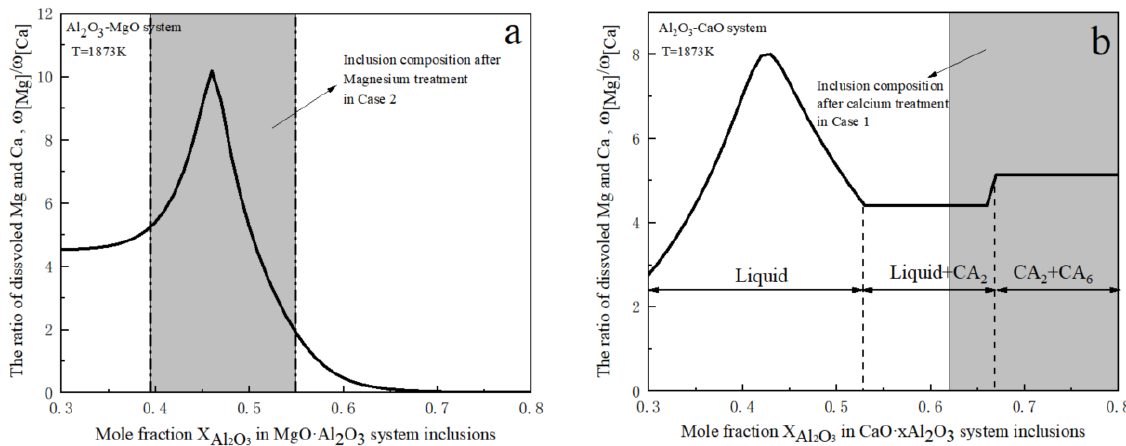
Figure 12. Ratio of Mg to Ca required for mutual transformation between Al 2 O 3 ·MgO ( a ) and between Al 2 O 3 ·xCaO ( b ).